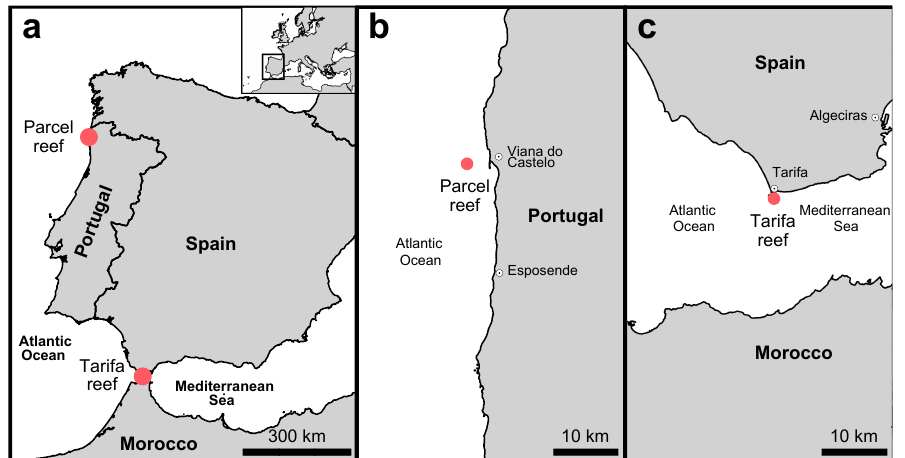
Figure 1. Sampling locations of temperate reefs in the South European Atlantic Shelf marine ecoregion in Iberian Peninsula Atlantic coastal waters ( a ), showing details of the sampling location in Parcel ( b ) in Northern Portugal (o ff Viana do Castelo) and in Tarifa ( c ) in Southern Spain (Strait of